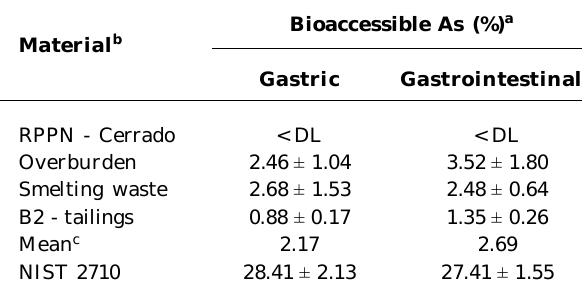
Figure 2. Mehlich-1 and bioaccessible arsenic in samples from the gold mining area. *gold mine tailings, except RPPN. < DL: below the detection limit (4 µg L 1 ). a,b particle size < 2 mm and < 150 µm, except for certified reference material (< 74 µm),